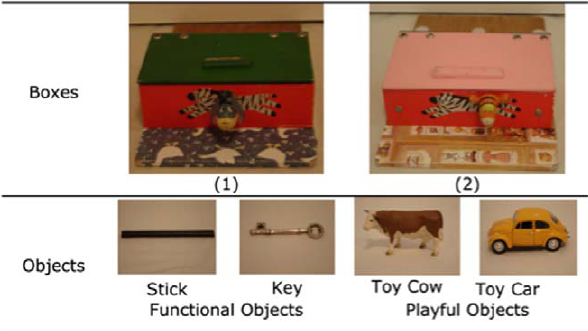
Figure 2. The boxes and objects used in this experiment.